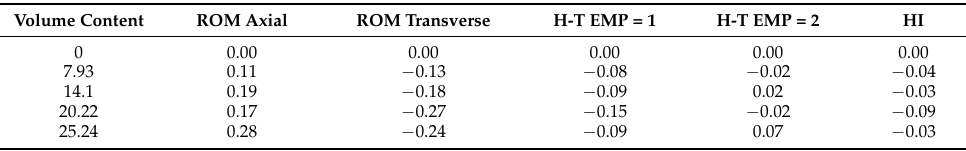
Table 7. Correlation between micromechanical data with experimental data for single ramie